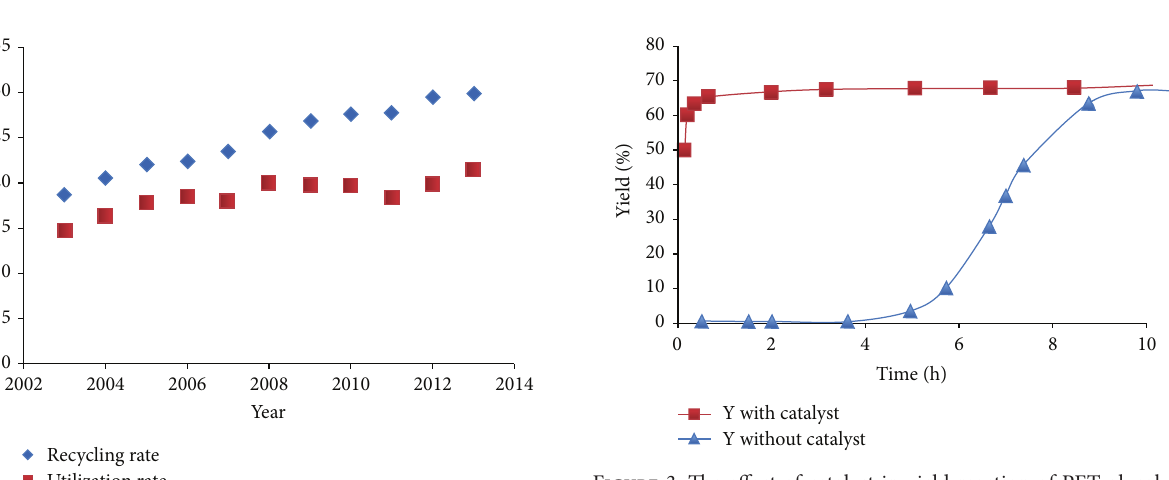
Figure 3: The effect of catalyst in yield reaction of PET glycolysis